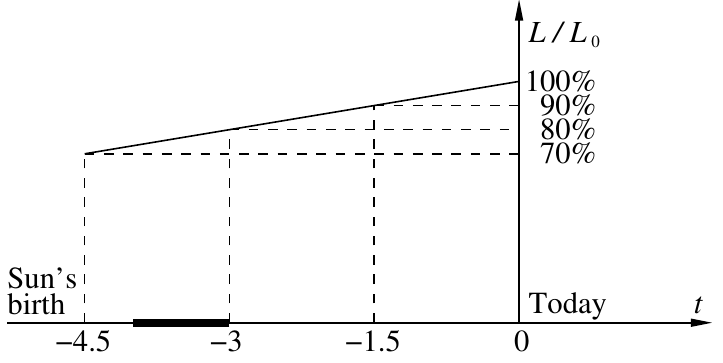
Figure 3. An idealized relative luminosity L / L 0 of the Sun, where L 0 is the solar constant and the time t is given in Gyr. The bold interval on the horizontal axis denotes the time period when life appeared on Earth and when liquid water was present on the surface of